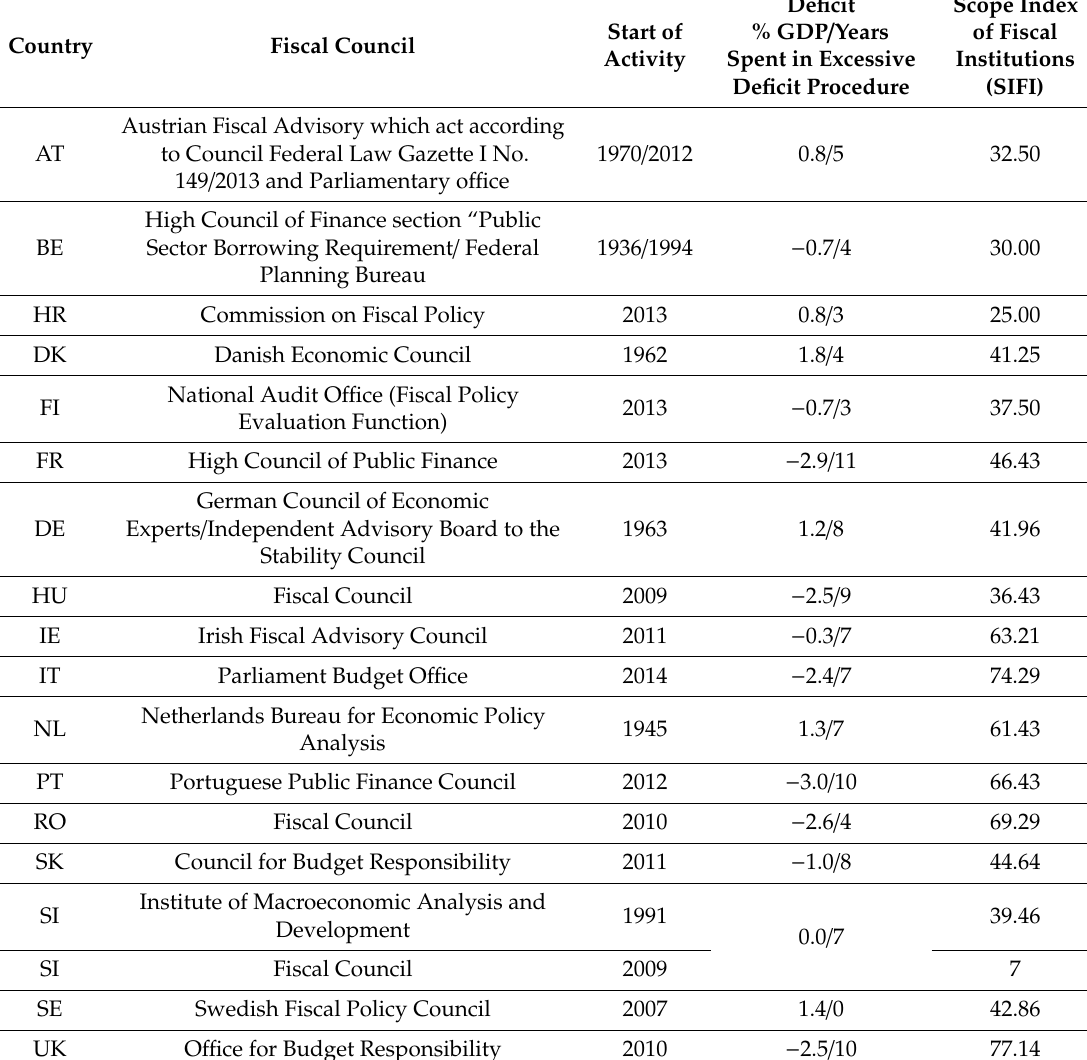
Table 2. Beginning of Fiscal Council activity in EU countries—Deficit and public Scope Index of Fiscal Institutions